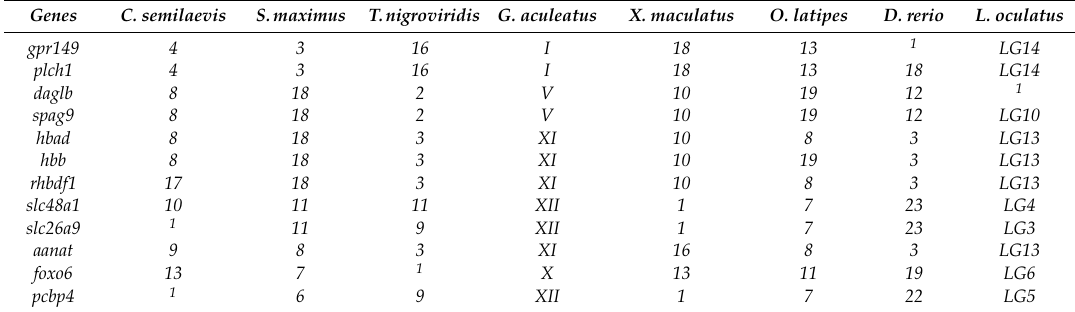
Table 2. Distribution of 12 genes out of 30 annotated in BAC53B20 on the chromosomes of the reference